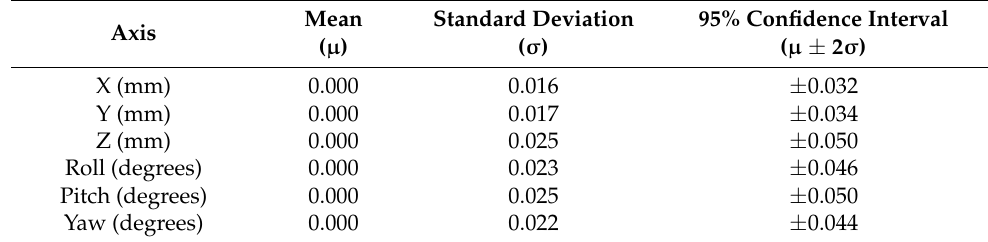
Table 3. Statistical characteristics of a 95% confidence interval for the top interface of an intersti- tial